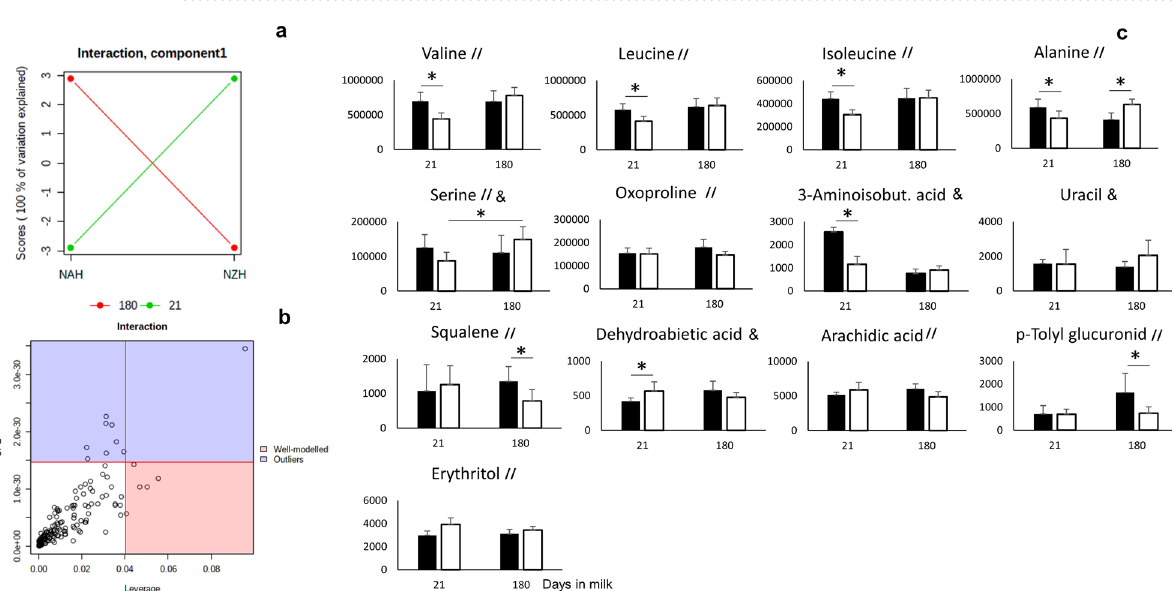
Figure 2. Genetic strain (North American Holstein, NAH, n = 8; New Zealand Holstein, NZH, n = 8) and days in milk interaction effect plots based on 1st component of ASCA ( a ), metabolites well modeled for ASCA interaction model ( b ) and bar plot of metabolites identified to have different temporal patterns between NAH and NZH cows according to ASCA (denoted by&) and/or top 10 MEBA’s ranking (denoted by //). Significant differences between means according to Tukey test are denoted by * whenever the ANOVA interaction effect P -value ≤ 0.10. The x-axis denote days in milk, the y-axis denote ion intensity peak height and error bars indicate standard